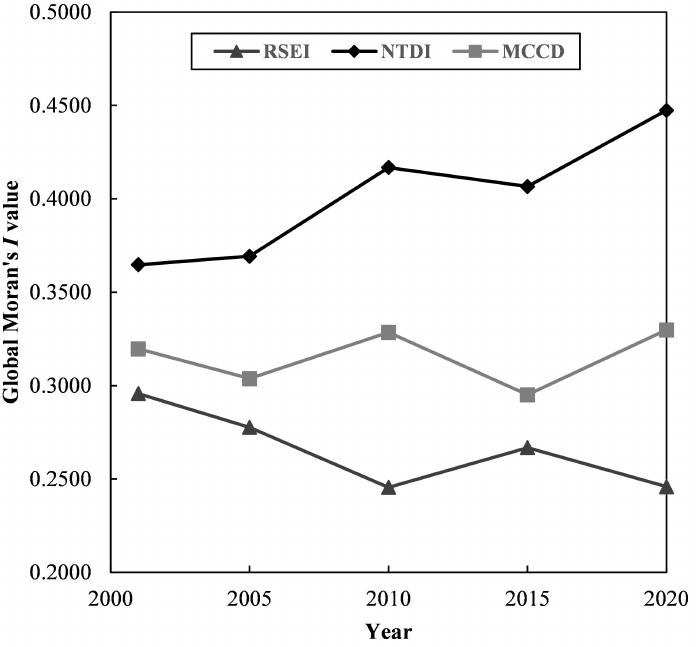
Figure 6. Global Moran’s I value change trend from 2001 to 2020 at the county